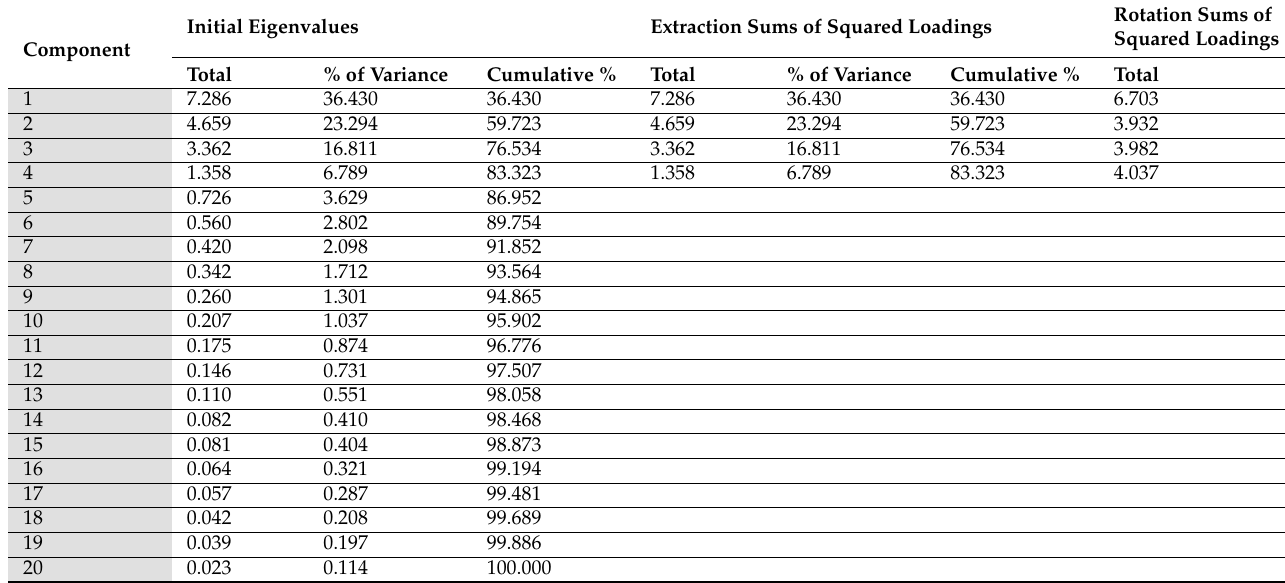
Table 7. Total variance explained for worker